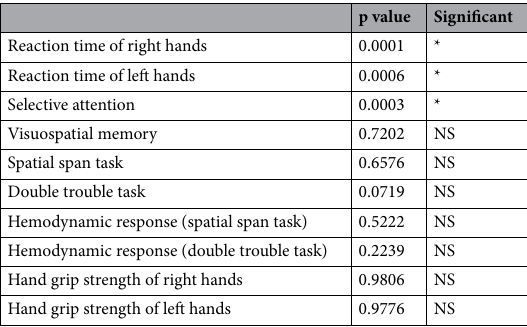
Table 2. Statistical analyses of data (significant; NS: non-significant: *).